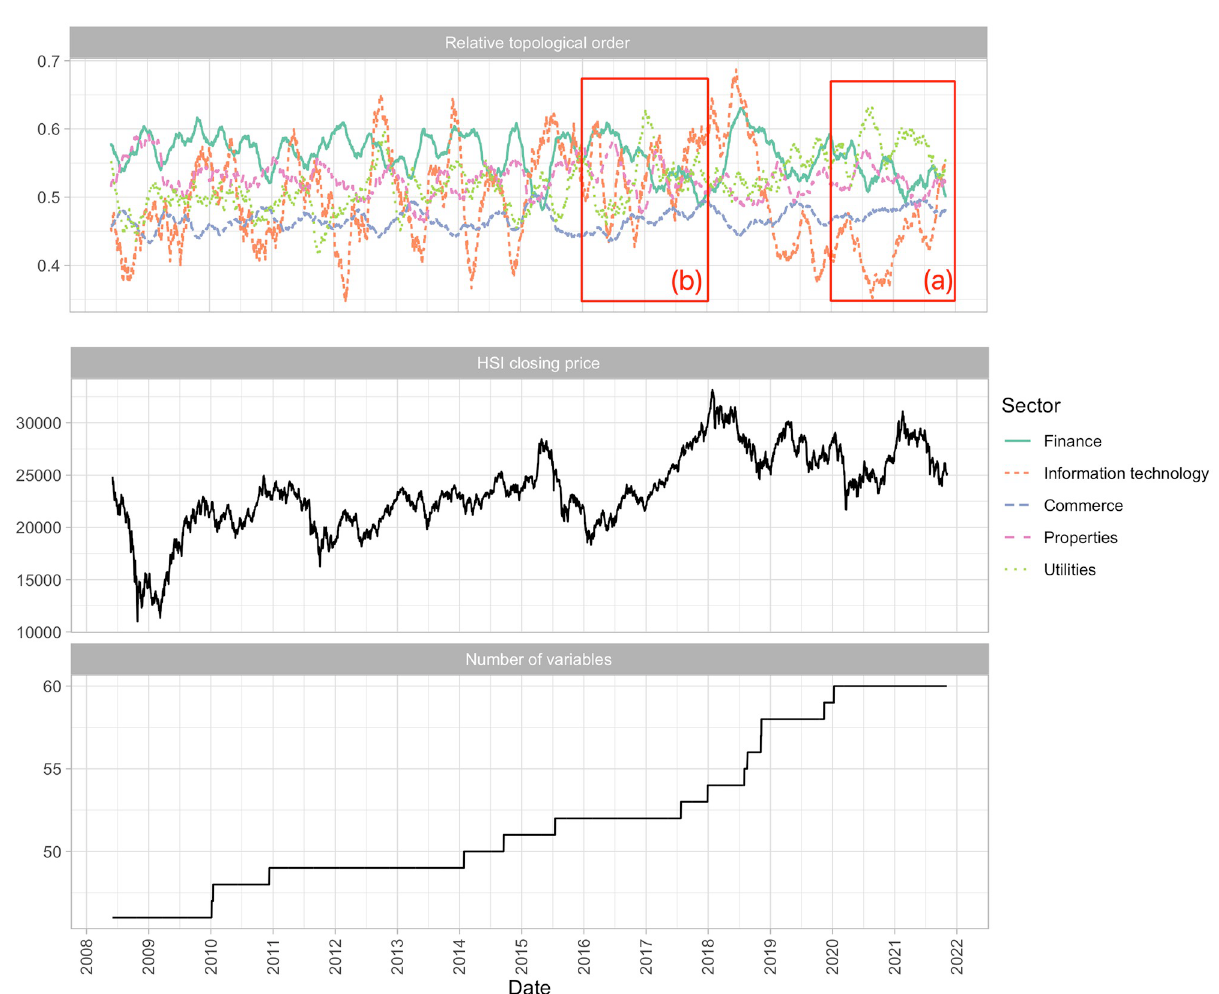
Fig 7. The time series plots of the smoothed average of the relative topological orders by sector, the daily closing price of the HSI and the number of variables in the networks from 2008 to